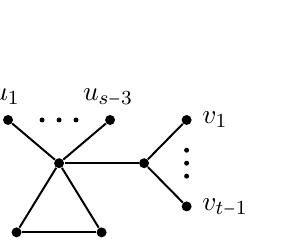
Fig. 5: The unsigned graph G ( s, t ) with s ⩾ 3 and t ⩾ 2